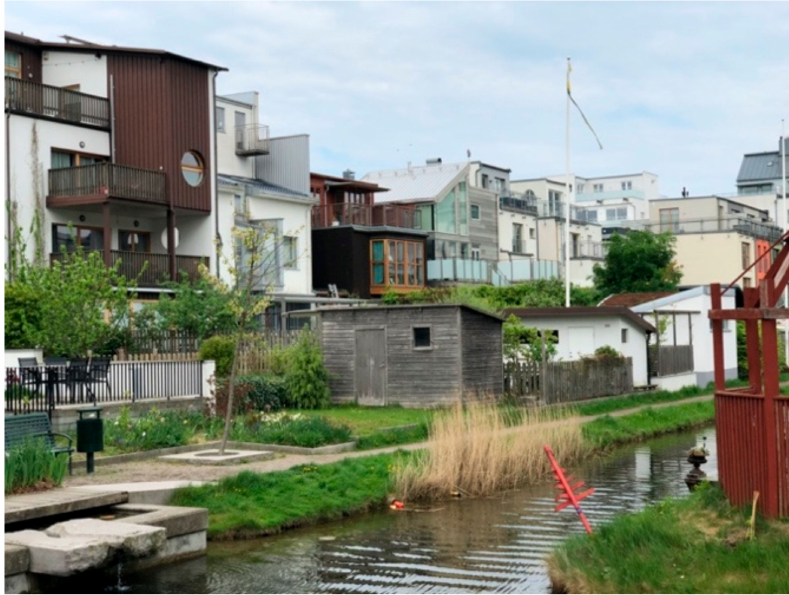
Figure 9. Photograph of case study 2: European Village. Source: authors.